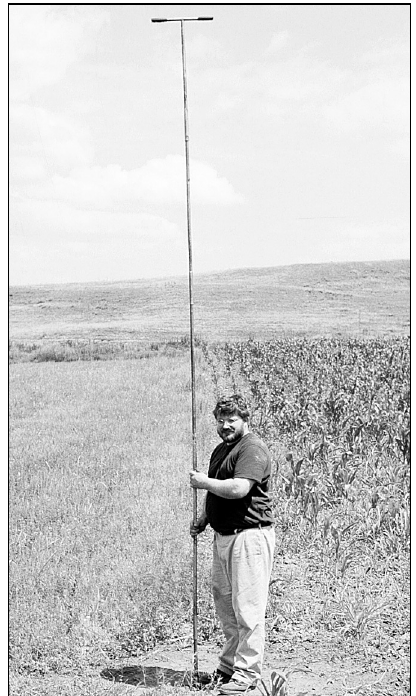
Figure 8 Taking sediment samples in the area of the putative Roman harbour at Noviodunum, using a hand auger down to a depth of 4.5m (auger hole 1 on Fig.